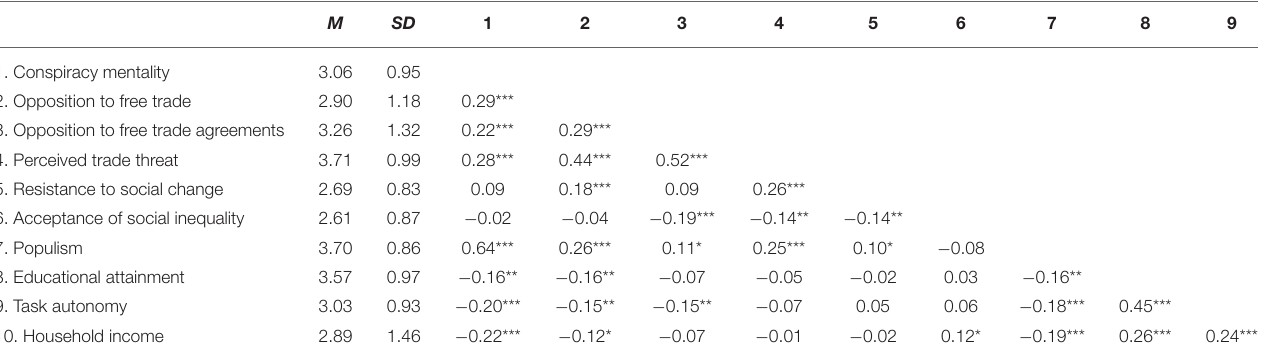
TABLE 2 | Descriptive statistics and correlations among the main study